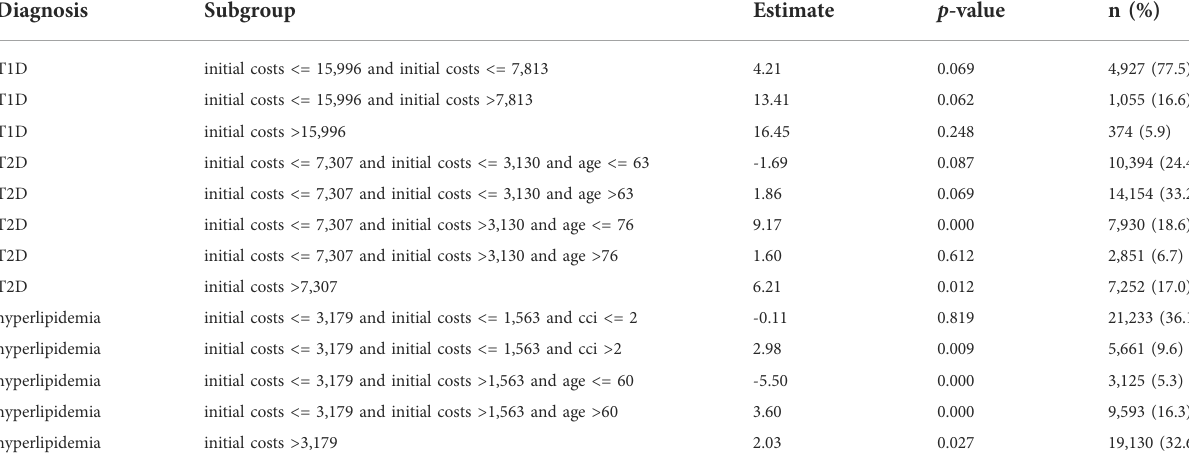
TABLE 2 Adherence effect estimates and subgroups detected by model-based decision trees. Diagnosis